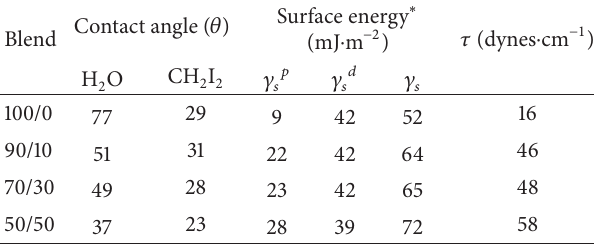
28 39 72 58 𝑠𝑝 = polar component, 𝛾 𝑠𝑑 = dispersive component, ∗ 𝛾 𝑠 = surface energy, 𝛾 and 𝜏 = water adhesion tension.